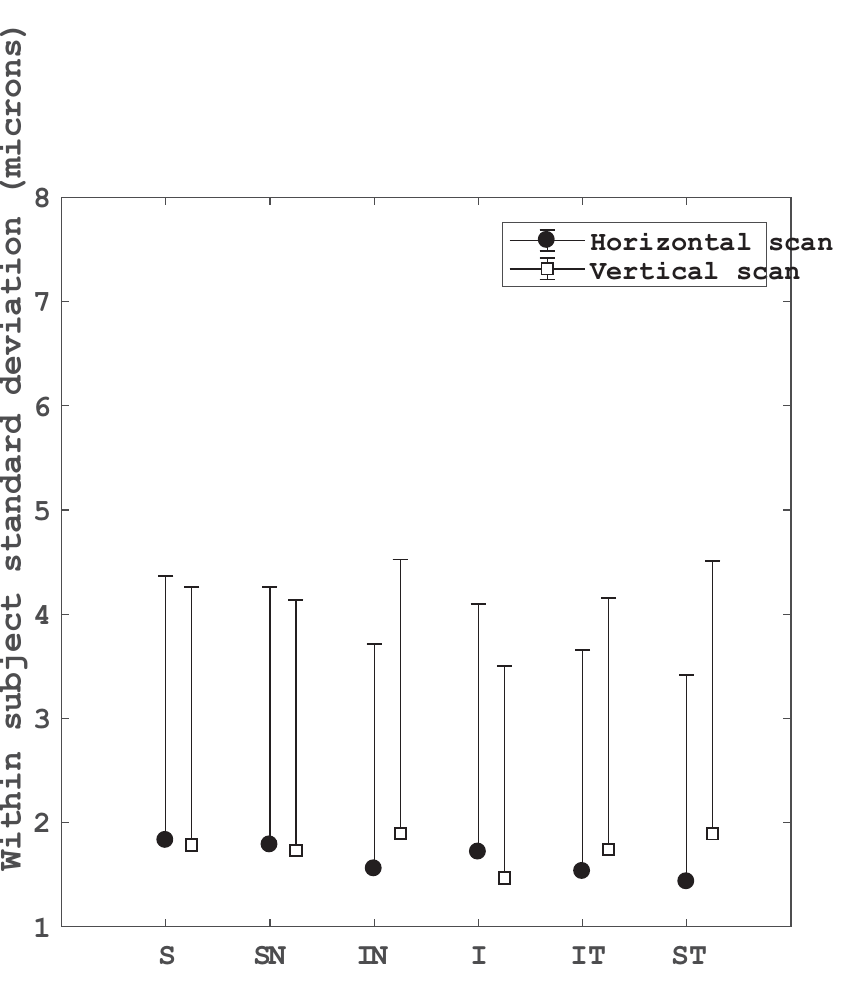
Fig 3. Intra-device repeatability for the inner limiting membrane to inner plexiform layer thickness in different sectors for horizontal and vertical scans. S: superior, SN: superior nasal, IN: inferior nasal, I: inferior, IT: inferior temporal and ST: superior temporal